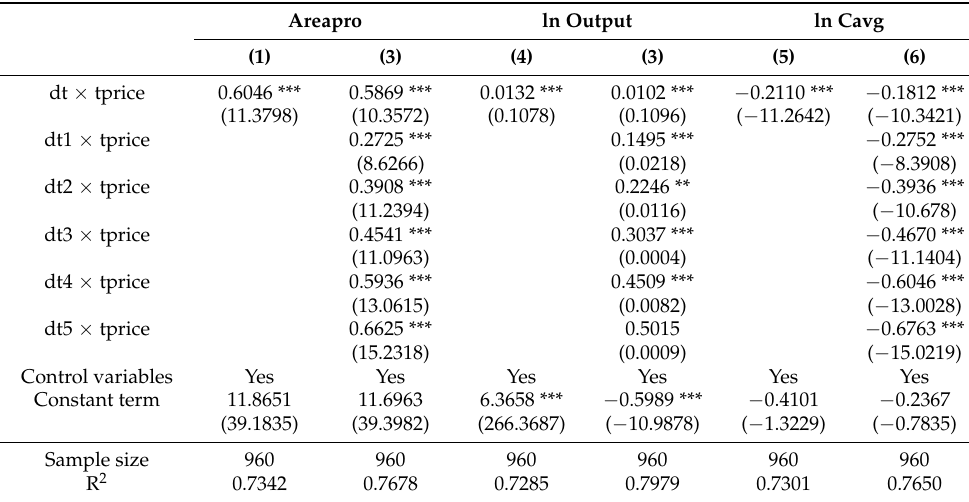
Table 6. The robustness test results of different matched